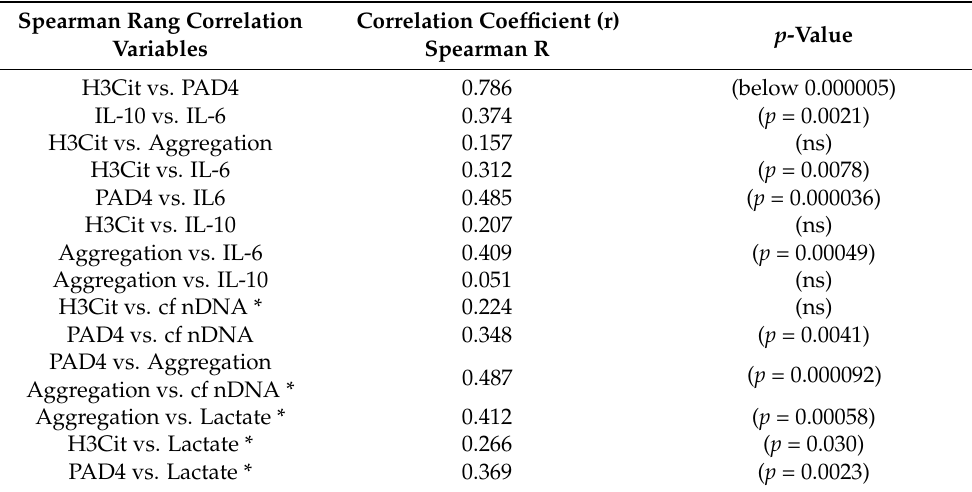
Table 4. Spearman’s ( ρ ) correlations between selected analyzed parameters before and after three repeated bouts of exhaustive treadmill